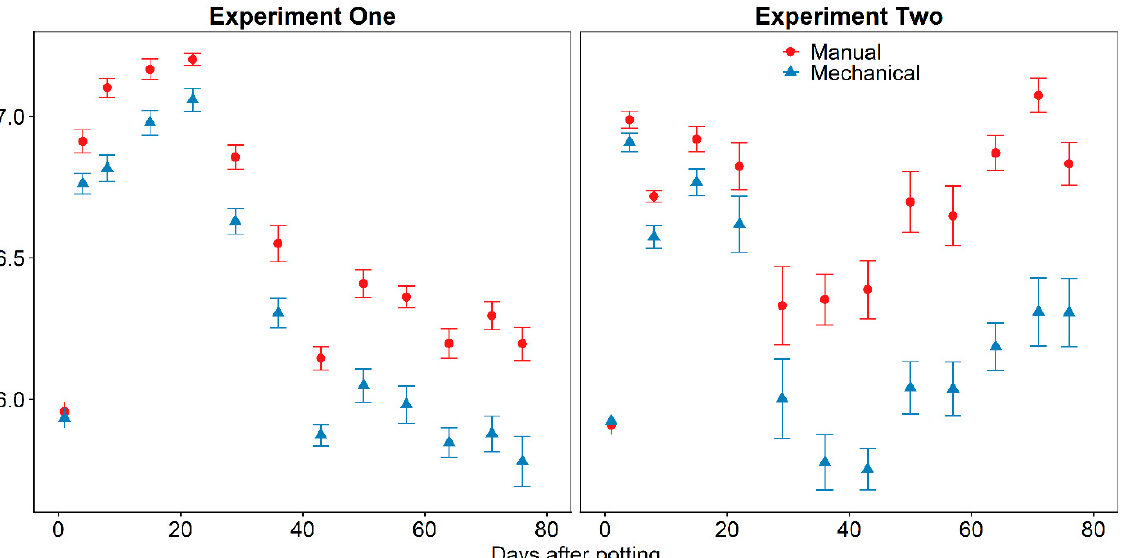
Figure 3. The pH of leachate from unplanted (Experiment One) or planted (Experiment Two) Douglas fir bark substrate and with either manually or mechanically incorporated Osmocote Plus 15-9-12 controlled release fertilizer. Error bars are standard error ( n = 10) of the mean. On day 29 of Experiment One, a single outlier was removed from the manually incorporated treatment ( n =